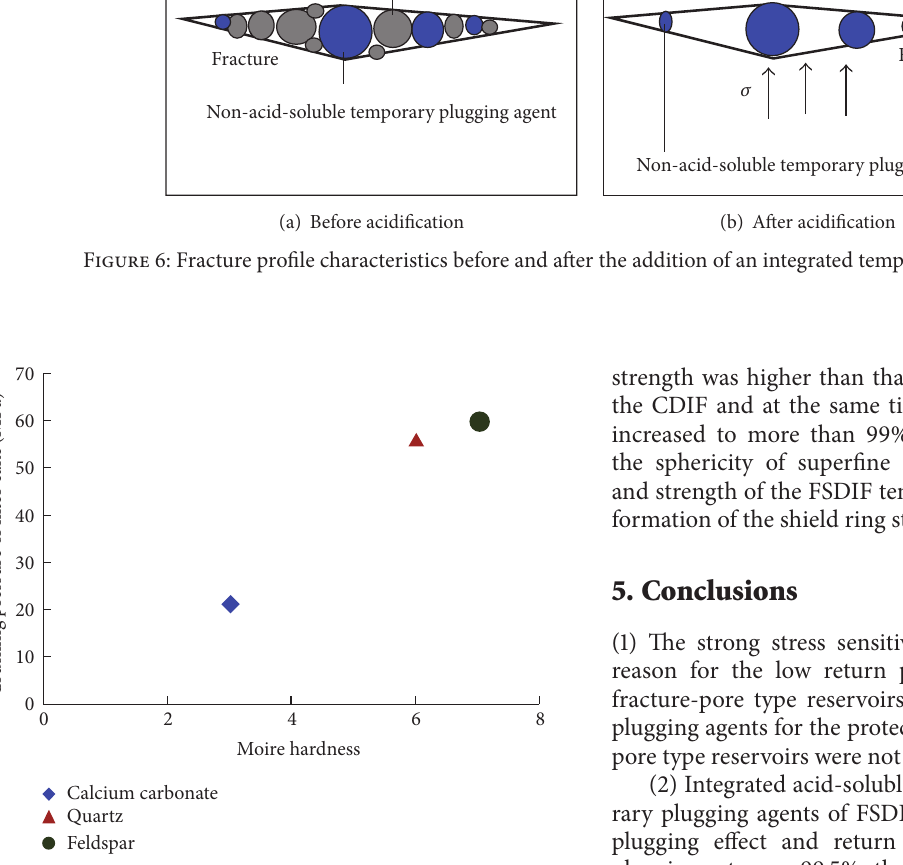
Figure 7: Strength of the filter cake formed by materials with different hardness (strengths) (according to Aadnoy et al., 2007).